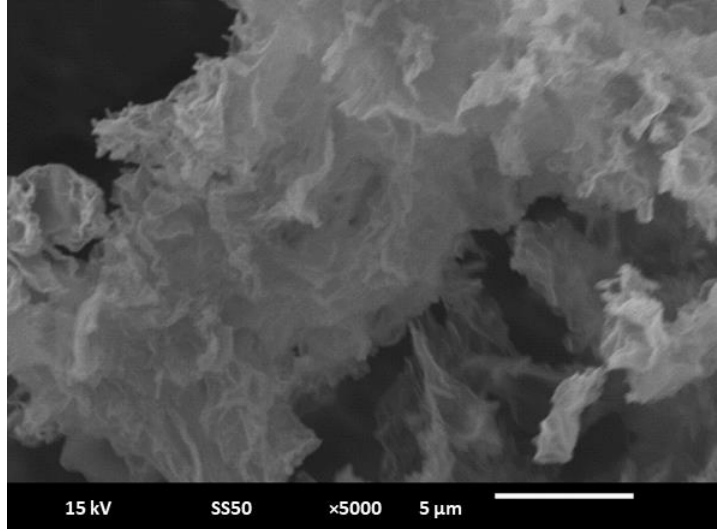
Figure 2. SEM image of RGO (scale: 5 µm).